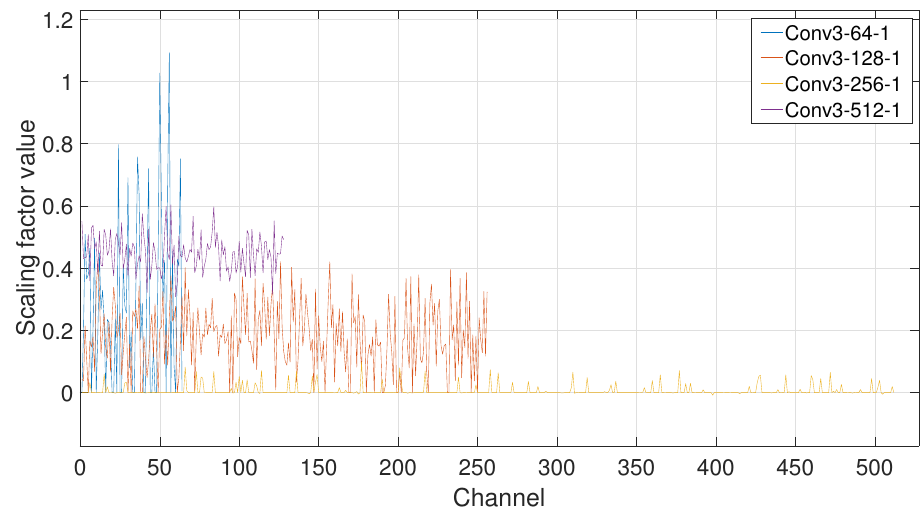
Figure 9. Distributions of scaling factors under different convolutional layers.